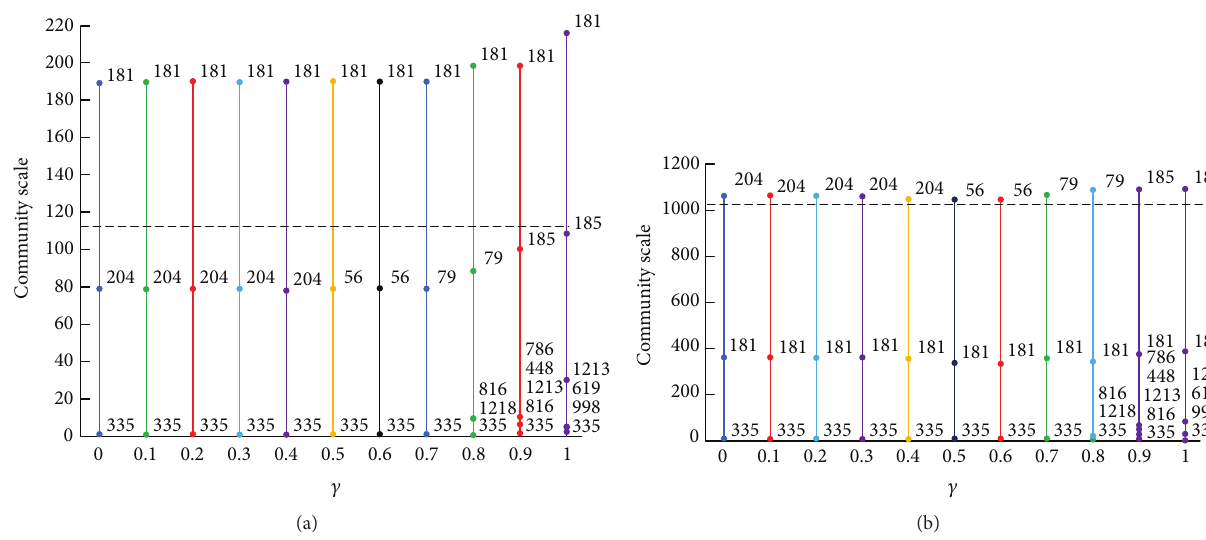
Figure 2: The community division result of MovieLens data set starting from resource nodes. The abscissa and ordinate denote the parameter value and community scale, respectively. Figure at left shows user communities and the one at right shows resource communities. The dotted horizontal lines show the number of users and resources, respectively, and solid vertical lines represent community distributions. Each segment of the solid line shows a community and the length denotes community size. The labels beside nodes are the identifiers of communities.